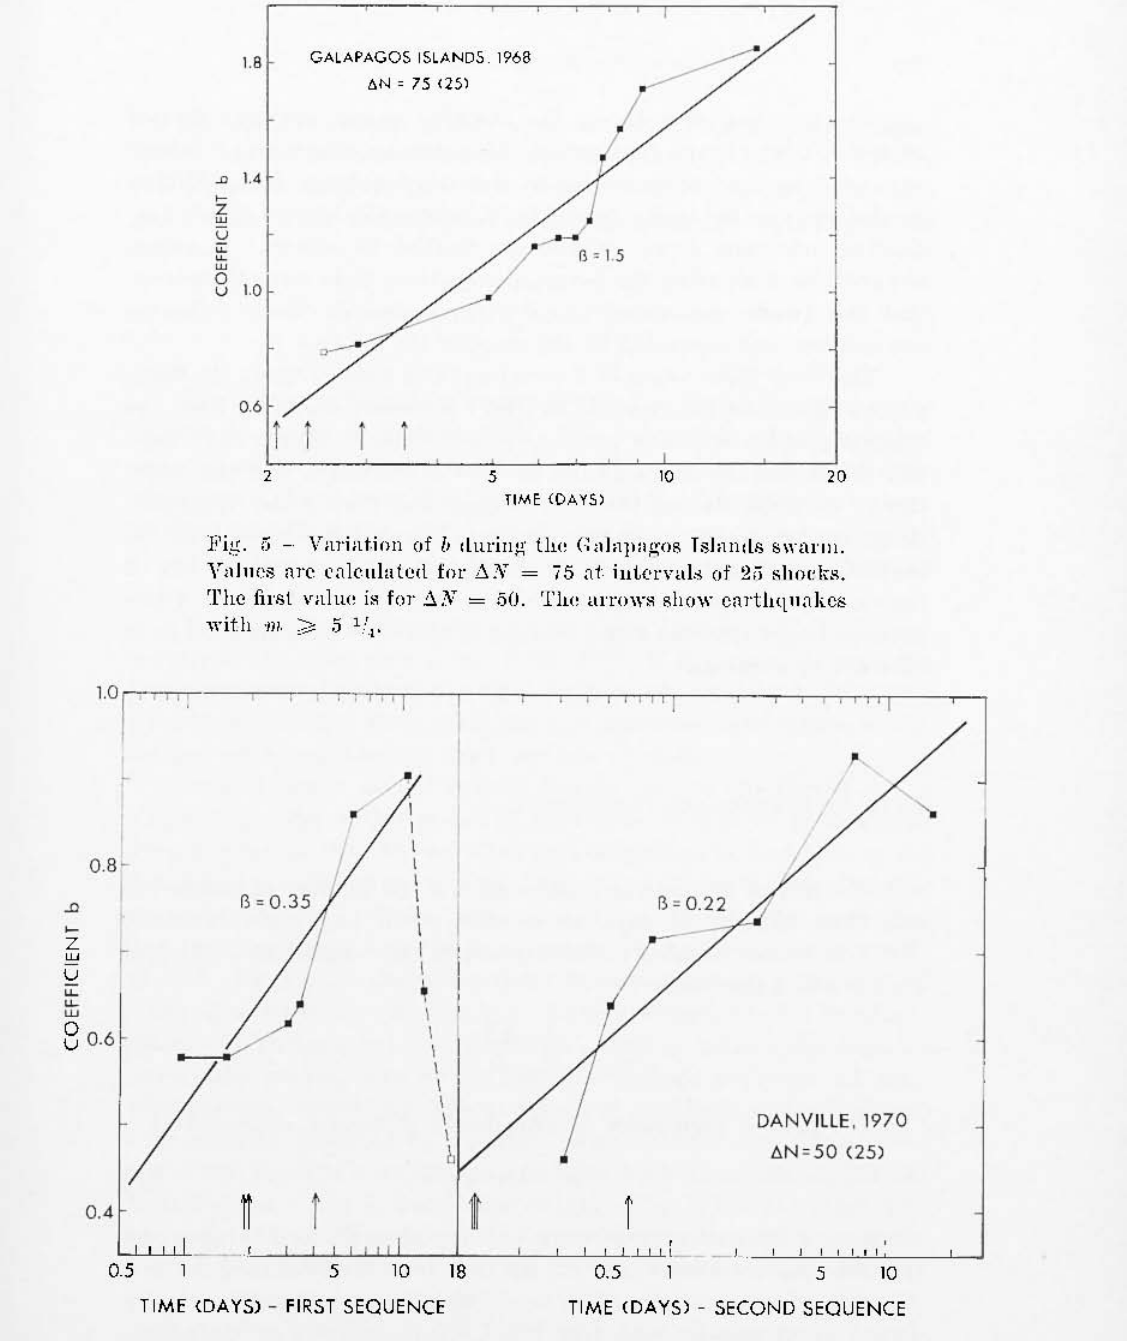
Fig. il - Variation of b ILurillg· Uw (;alH]l:lg"os TslHnlLs 8\HII"II1. Vahws Hrc calcllLatell for f..N = 75 ai illterl'al.~ of 2:; ~hoeks. The Ihst l'ahw is for !:l.Y = 50. 'l"lw HlTOWS show carthl[llakcs with m. > - " ,c-